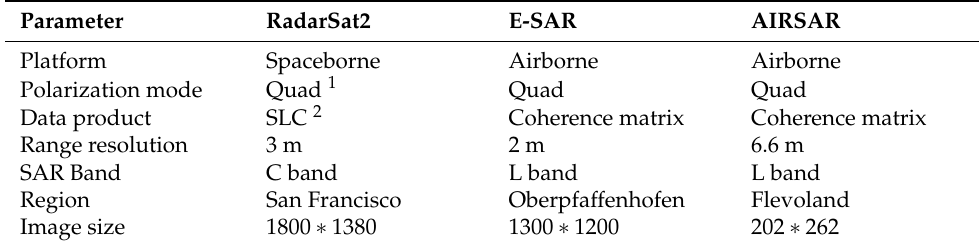
Table 1. Experimental data parameters.